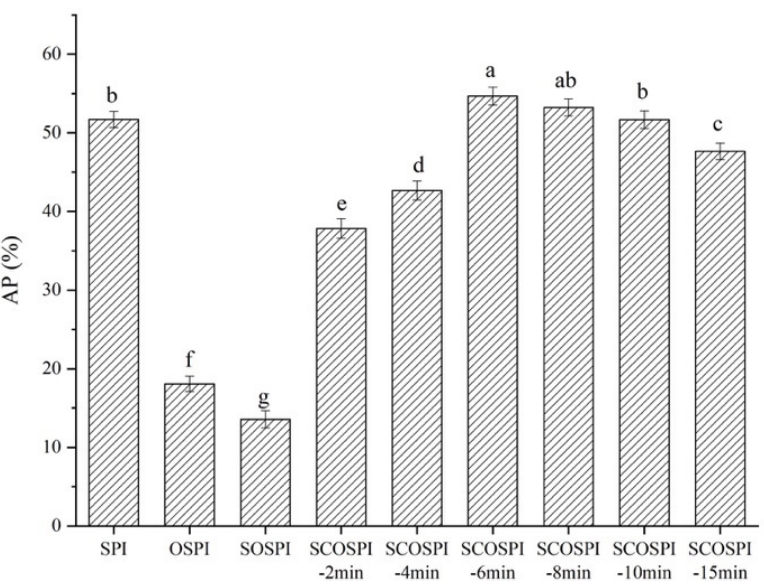
Figure 7. AP% of emulsions of natural, oxidized soybean protein, and cavitation jet treated on soluble soybean protein oxidized accumulates at several times (2, 4, 6, 8, 10, and 15 min). Note: Values with a different letter(s) indicate a significant difference at p ≤